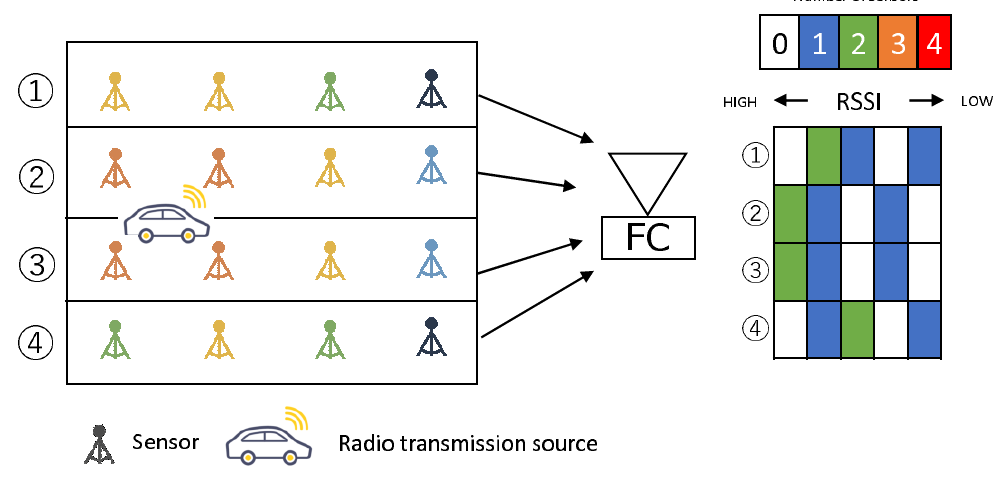
Figure 11. Aggregation